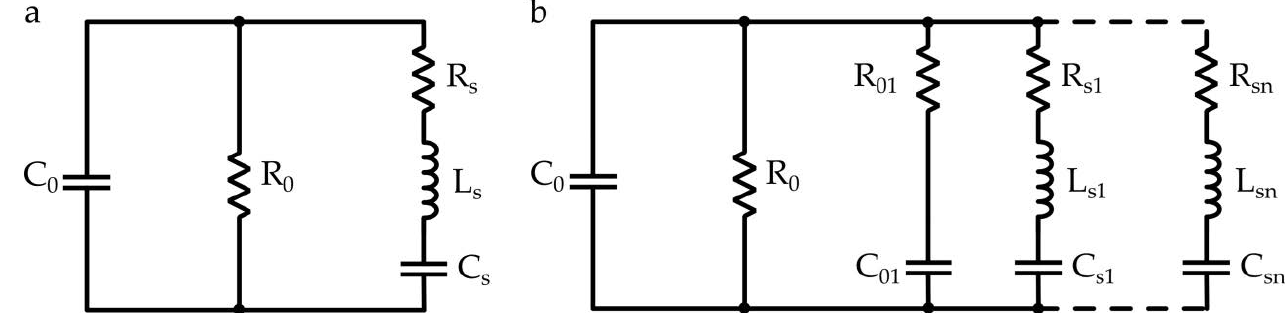
Figure 1. ( a ) Hemi-cylindrical PVDF equivalent model based on the BVD theory. ( b ) Spiral-shaped PVDF modified BVD model considering multiple resonances.